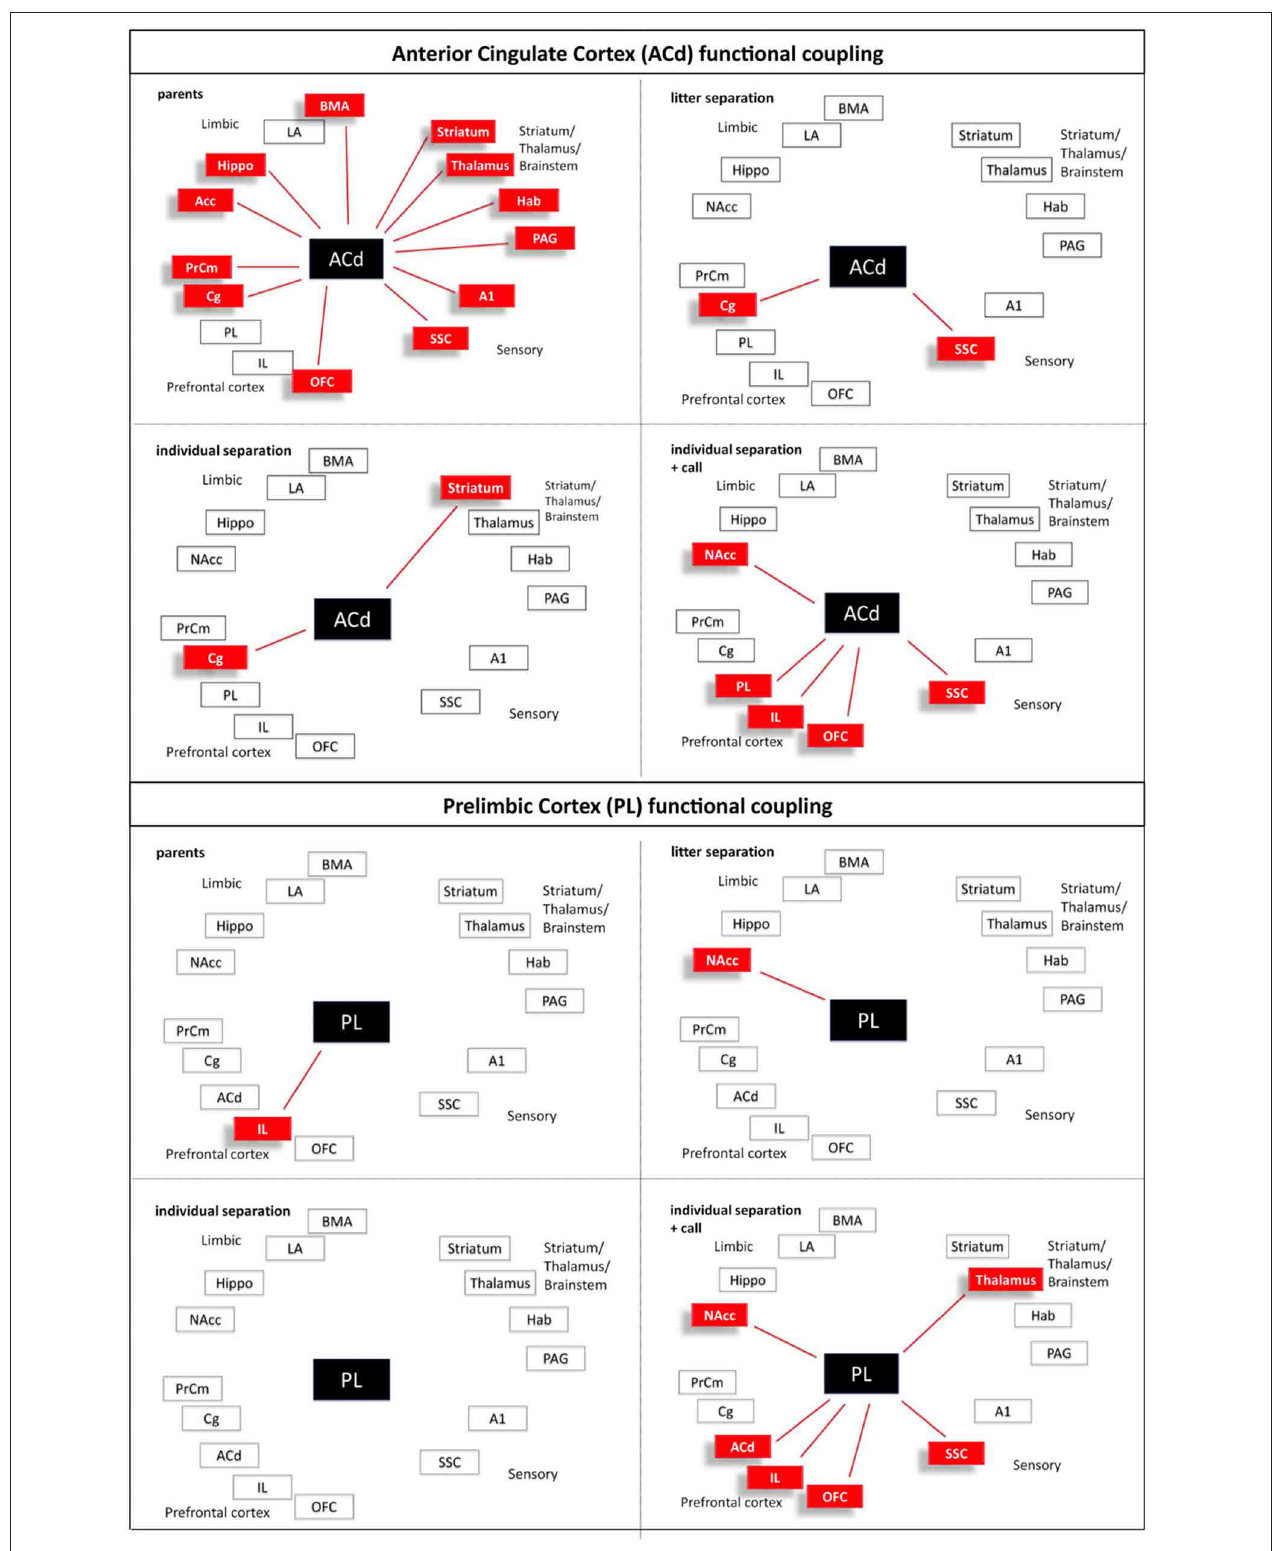
FIGURE 6 | Interregional functional coupling of the anterior cingulate (ACd) and prelimbic (PL) cortex under different stress conditions. Red color indicates positive correlations ( p < 0 . 05).